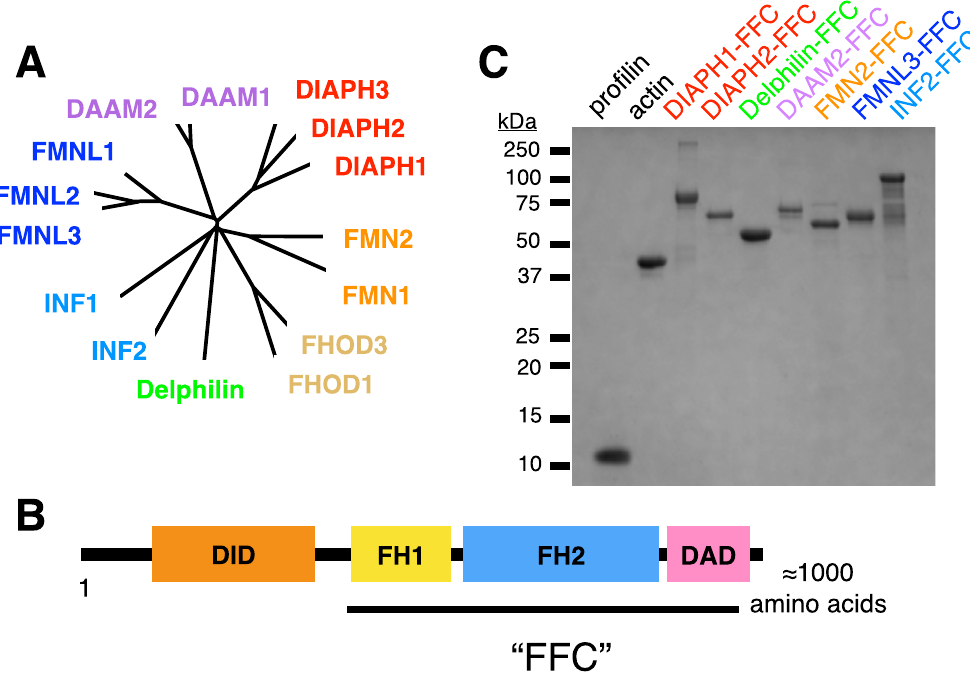
Figure 1. Formin constructs and purification. ( A ) Phylogenetic tree of formins based on DeWard et al. 2 To assay diverse human formins, we selected representatives of six of the seven mammalian formin subclasses. ( B ) ‘FFC’ constructs, which include the FH1 and FH2 domains and all C-terminal sequences, were isolated for each formin (DID, Diaphanous Inhibitory Domain; DAD, Diaphanous Autoregulatory Domain). ( C ) SDS-PAGE showing the purity of each recombinant formin FFC fragment after purification by Coomassie staining (see Figure S7 for uncropped